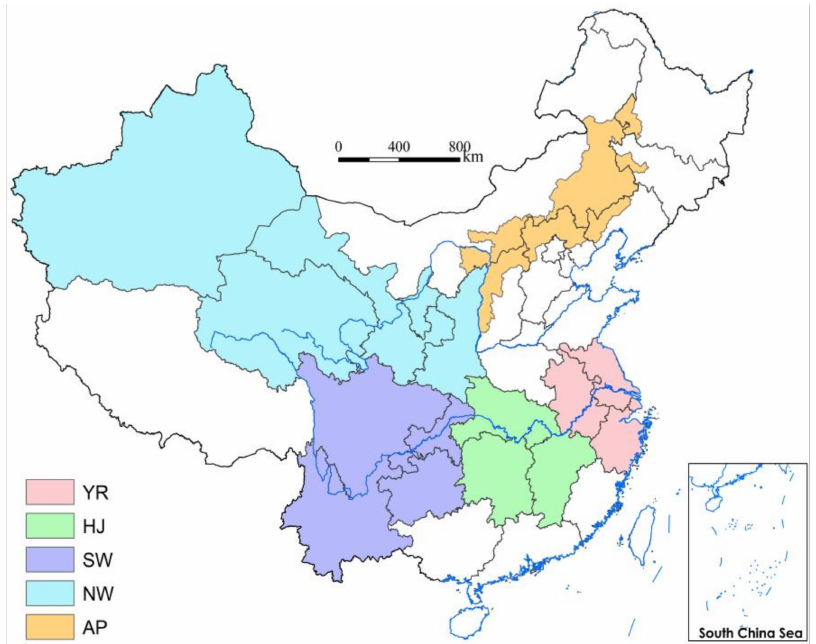
Figure 1. Location of the study